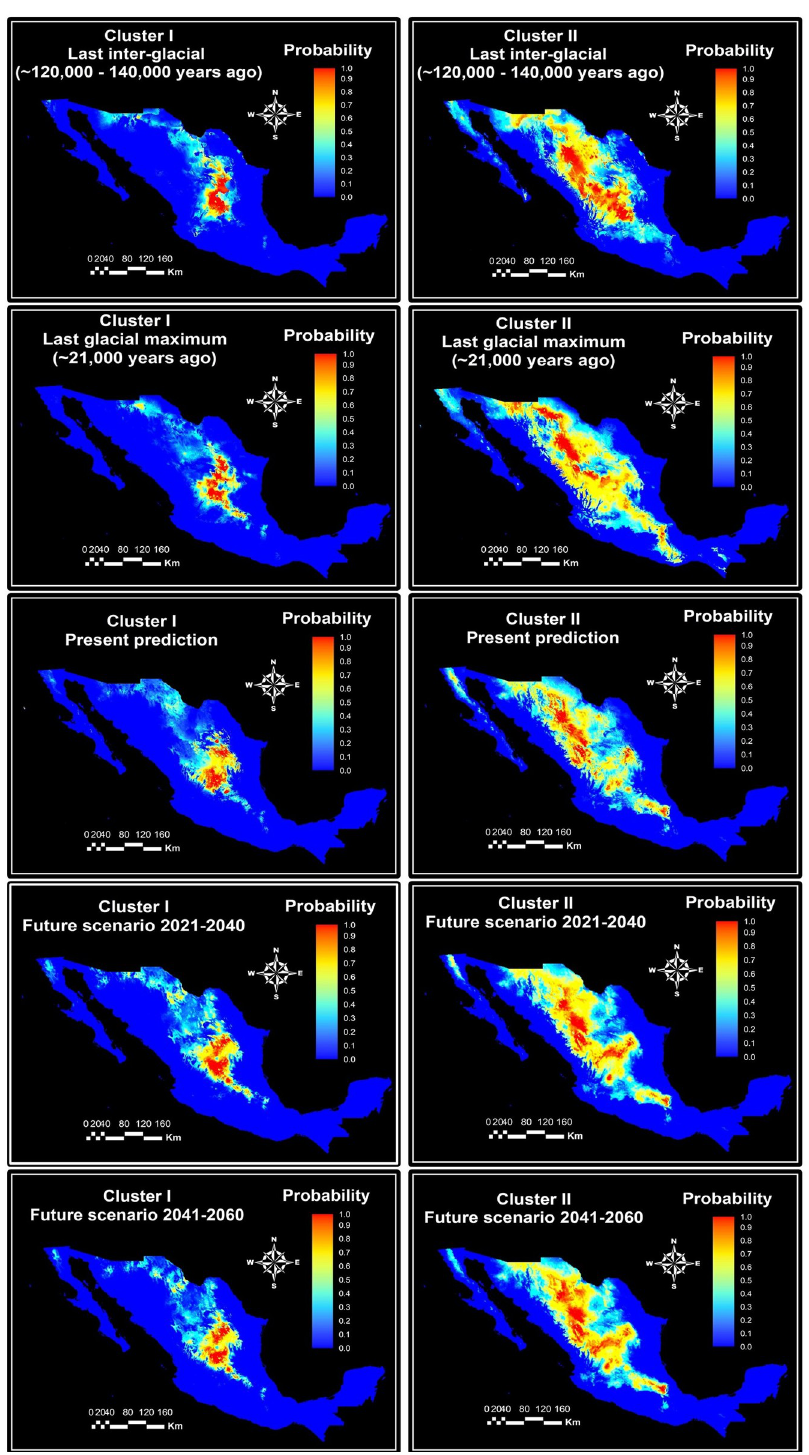
Fig 5. Past, present and future MaxEnt niche models for two genetic cluster of sideoats grama ( Bouteloua curtipendula ). Maps represent the average projections of the models to the last interglacial (120,000–140,000 years ago), last Glacial Maximum (22,000 years ago), historical data (1970–2000), near future (2021–2040) and mid-century (2041–2060). Genetic clusters were identified through AFLP markers and STRUCTURE analyses of 85 populations. Scale corresponds to probability of occurrence (habitat suitability).